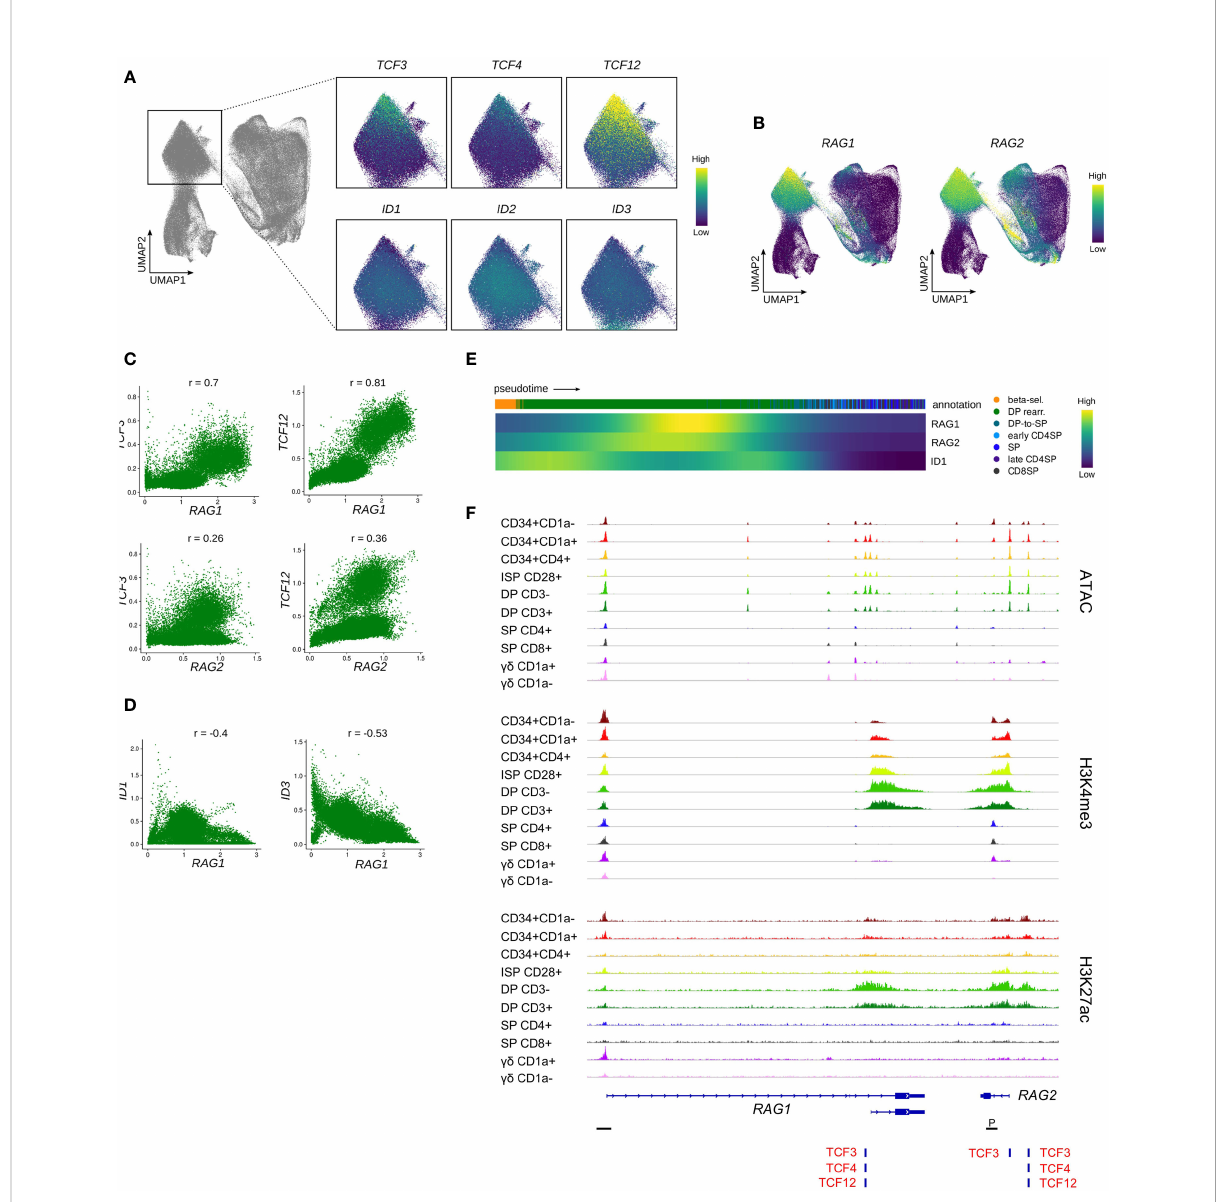
FIGURE 8 Transcription of E protein encoding genes is associated with RAG expression in rearranging DP thymocytes. (A) UMAP visualization of E and ID protein encoding gene expression in the rearranging DP thymocyte cluster. (B) UMAP visualization of RAG1 and RAG2 expression according to the single cell thymocyte data set. Transcripts were imputed prior to visualization. (C) Scatter plot for imputed transcript levels of TCF3 , TCF12 , RAG1 and RAG2 in rearranging DP thymocytes. Pearson correlation coef fi cient is shown. (D) Scatter plot for imputed transcript levels of ID1 , ID3 , and RAG1 in rearranging DP thymocytes. Pearson correlation coef fi cient is shown. (E) Heatmap showing gene expression along differentiation pseudotime in DP and SP thymocytes. Smoothed gene expression was determined based on a generalized additive model fi tted on the cell pseudotimes, cells in pseudotime window of interest were selected and expression was scaled by gene prior to visualization. (F) Genome browser view of ATAC, H3K4me3, H3K27ac and E protein motifs at regulatory regions of the RAG gene locus. Locations of promoters (P) were retrieved from the Ensembl Regulatory Build and are indicated below the gene